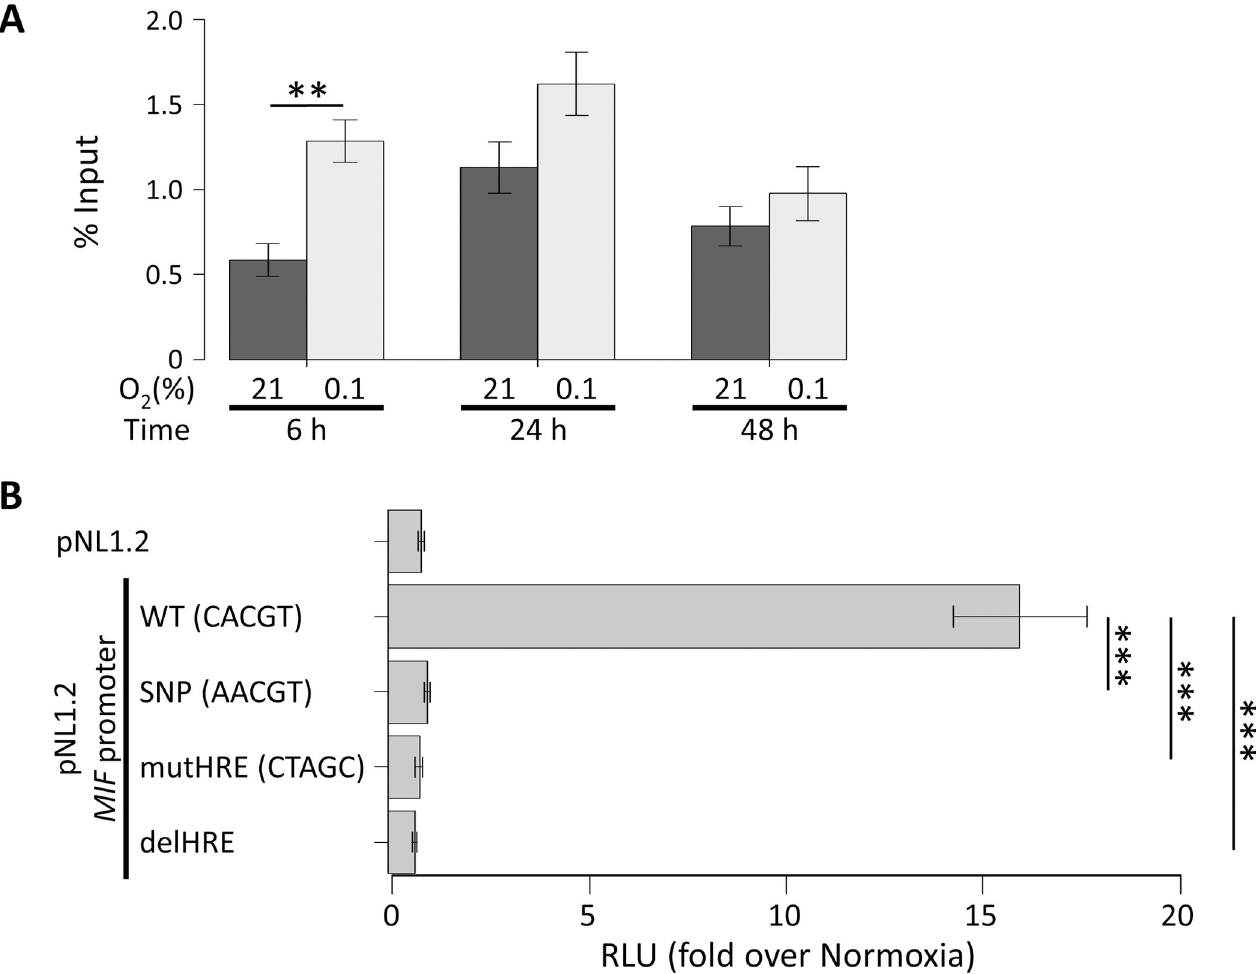
Fig 3. Hypoxia-inducible factor (HIF) binding to the hypoxia response element (HRE) induced activation of the macrophage migration inhibitory factor ( MIF ) gene promoter under hypoxia, that was abrogated by the allelic variant of the HRE. A. The effects of hypoxia on HIF binding at the MIF gene promoter in primary cultured astrocytes (PCAs). PCAs were incubated for 6, 24, or 48 h in 21.0% or 0.1% O 2 . HIF-1 α binding to the MIF gene promoter was analyzed by chromatin immunoprecipitation (ChIP) assay. Real-time PCR was performed on DNA purified from each of the ChIP reactions by using a primer set specific for the MIF gene promoter. The % input values indicate the ratio of immunoprecipitated DNA fragments to the input DNA fragments (Student’s t- test after logarithmic transformation; n = 6). B. The allelic variant of the HRE abrogates MIF induction by hypoxia in PCAs. PCAs were transfected with a reporter plasmid containing the MIF genomic region ( − 335 to − 1) upstream of the Nanoluc luciferase reporter gene and a control plasmid containing the firefly luciferase reporter gene. Where indicated, the wild type (WT) HRE sequence (CACGT) was mutated to AACGT (SNP), CTAGC (mutHRE), or deletion (delHRE). At 24 h after transfection, PCAs were incubated for 24 h in 21.0% or 0.1% O 2 . The graph represents the corrected luciferase activity values of each construct in cells exposed to hypoxia over the luciferase activity obtained in normoxic cells (Dunnett’s test; n = 9–14). The data are expressed as the mean ± SEM. � p < 0.05, �� p < 0.01, or ��� p <